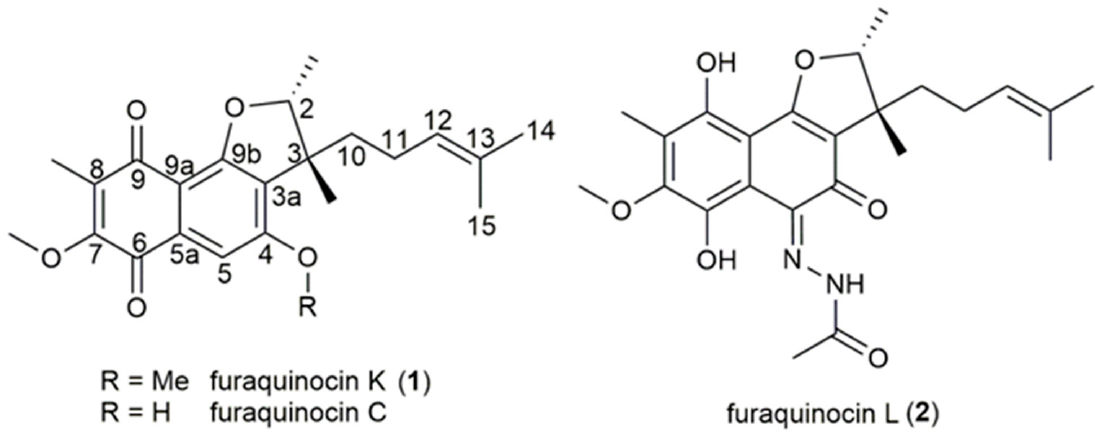
Figure 1. Furaquinocin C and the new furaquinocins K ( 1 ) and L ( 2 ). Furaquinocin K contains two stereo centres at C-2 and C-3, which are in the 2R and 3R configuration in all naturally occurring furaquinocins [18]. To confirm this finding, the optical rotation value of furaquinocin K, [ α ] D23 = − 78 ◦ , was compared with those of furaquinocin C (2 R , 3 R ; [ α ] D23 = − 25 ◦ ) and its synthetic epimer 3-epifuraquinocin C (2 R , 3 S ; [ α ] D 23 = +58 ◦ ) [19]. The negative value determined for furaquinocin K supported the expected 2 R , 3 R